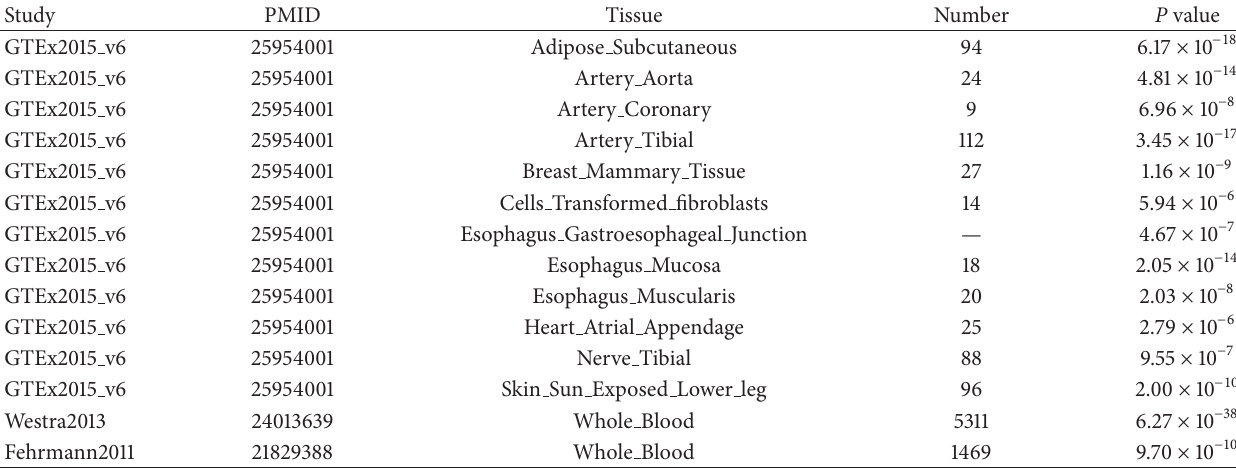
Table 1: cis -eQTL effect of rs3828903 in multiple tissues in HaploReg v4.1